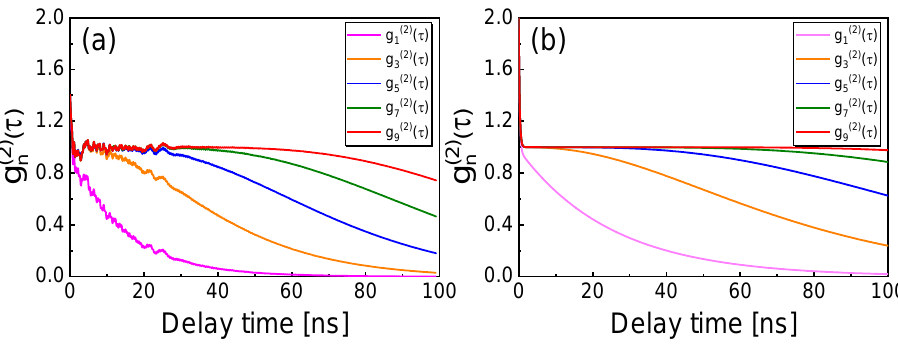
( 2 ) ( τ ) within the delay time 100 ns. g  within the delay time 100 ns. Figure 5. The ( a ) experimental and ( b ) theoretical results of g n n